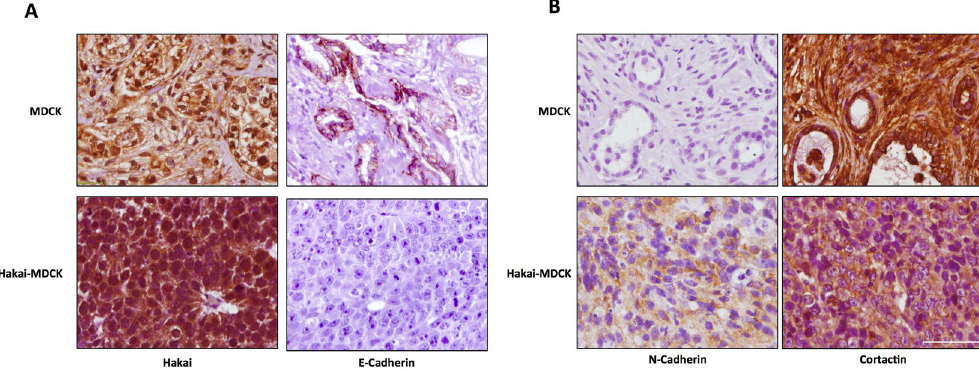
Figure 4. Hakai overexpression induces tumours with mesenchymal phenotype in xenografts mouse model. (A) Immunohistochemical staining for E-cadherin and Hakai in tumours originated by MDCK and Hakai- MDCK cells (MDCK, n = 2; Hakai-MDCK, n = 5). Representative images were taken with a 40x objective. Scale bar, 125 μ m. (B) Representative immunoreactivity of N-cadherin and Cortactin in tumours originated by MDCK or Hakai-MDCK cells (MDCK, n = 2; Hakai-MDCK, n = 5). Representative images were taken with a 40x objective. Scale bar, 125 μ